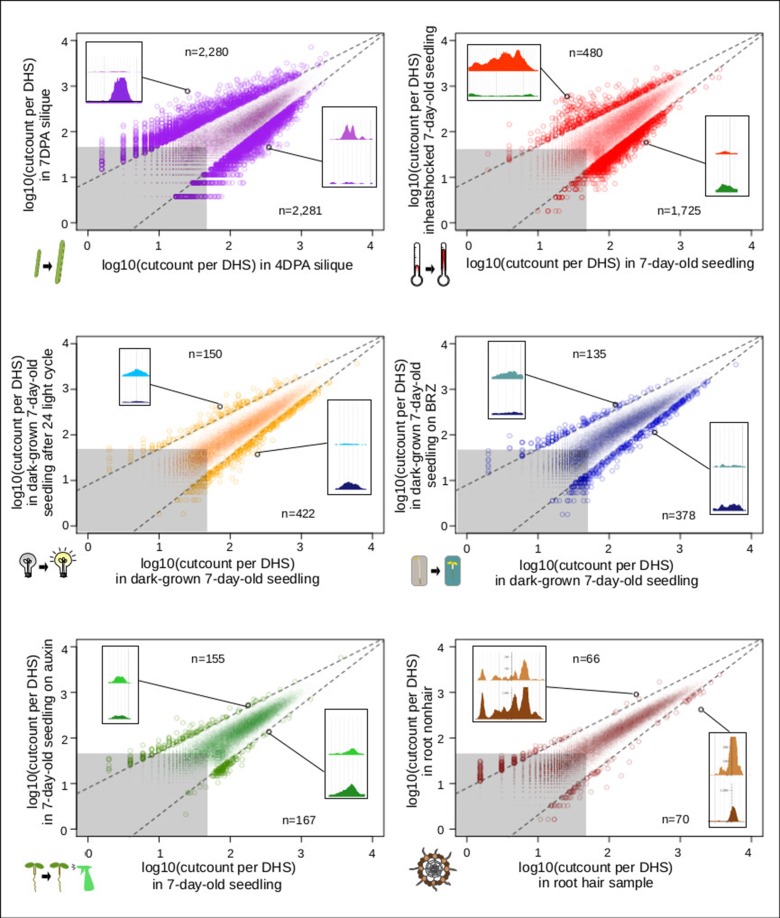
Comparison of seed coat-enriched samples (4 and 7 DPA) results in the highest number of developmentally dynamic DNase I-hypersensitive sites (DHSs) identified among all pairs examined. Scatterplots of log10(cut counts per union DHS) for six pairwise comparisons. Dotted lines creating a cone capturing the majority of the dots are drawn in the same location on each graph. Gray boxes represents regions in which both samples have less than 50 [log10(50) = 1.69897] cleavage sites in that DHS. Numbers indicated above and below indicate the number of dots (DHSs) that lie above and below dotted lines. Screenshot insets in each graph showing an example dynamic DHSs above and below dotted lines are the following DHSs, respectively: {4 vs. 7 DPA: chr2:19,564,381–19,564,531, chr4:11,981,161–11,981,351; root hair vs. root nonhair: chr1:30,035,761–30,036,071, chr4:280,861–281,131; control vs. auxin-treated: chr1:10,320,801–10,321,131, chr1:5,204,361–5,204,551; dark-grown seedling vs. dark-grown seedling on BRZ: chr5:22,570,821–22,571,231, chr5:21,869,241–21,869,591; control vs. heat shocked seedling: chr4:7,338,681–7,342,041, chr2:18,374,201–18,374,371; dark-grown seedling vs. dark-grown seedling exposed to 24-h light cycle: chr3:6,023,601–6,023,871, chr5:5,968,041–5,968,291}.